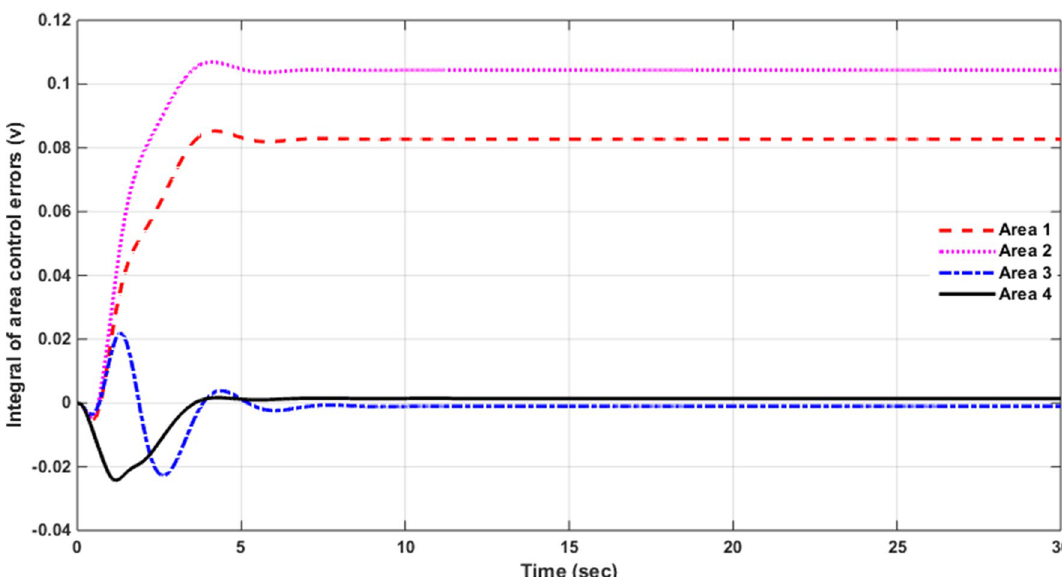
Figure 7. Integral of area control errors in four areas with no